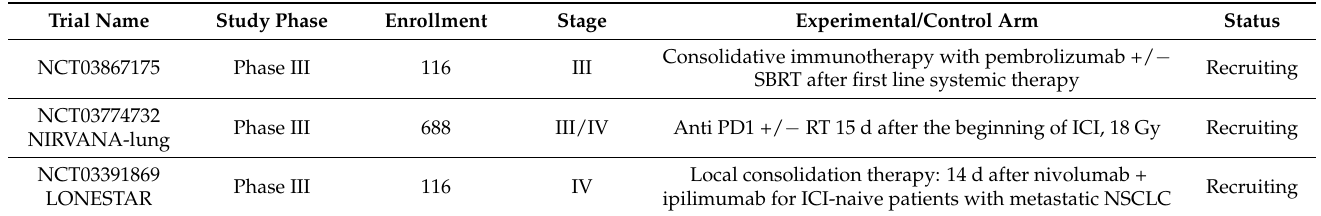
Table 2. Main ongoing phase III trials with ICI/RT combinations in advanced